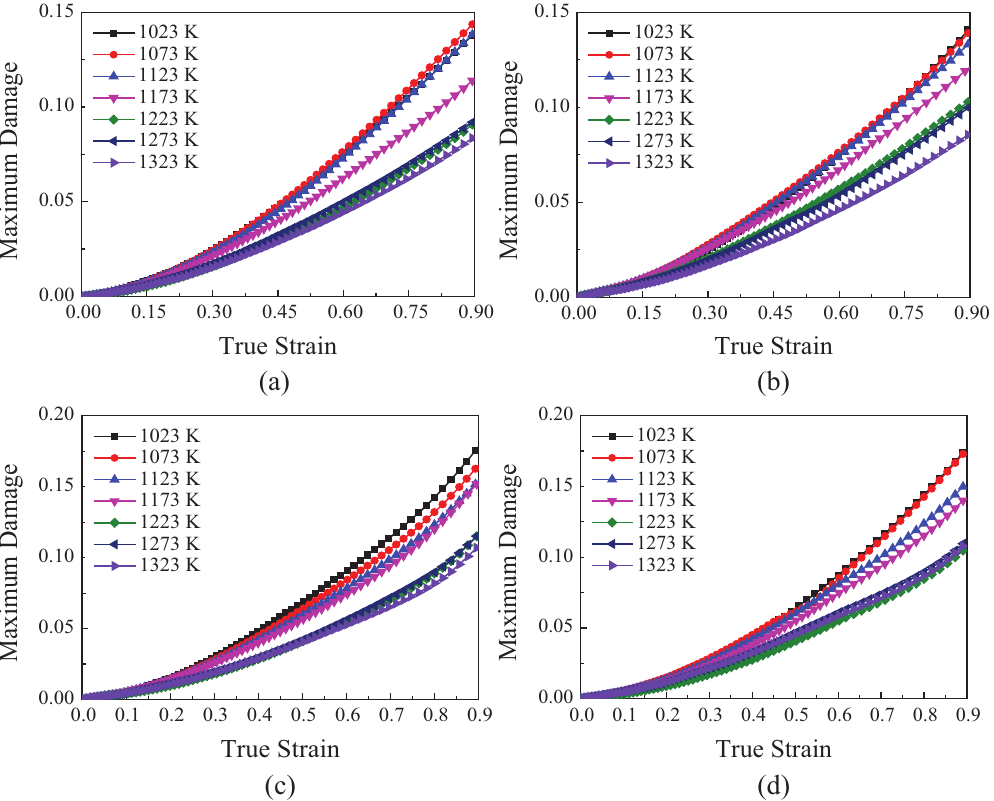
Figure 5: The maximum damage varying during compressing process at different temperatures and strain rates (a) 0.01 s − 1 , 1023 K ~ 1323 K;